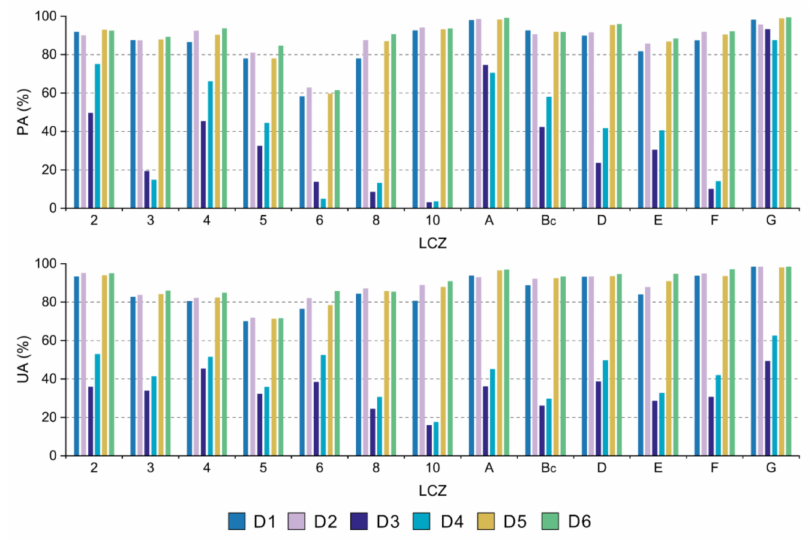
Figure 5. Producer’s accuracies (PAs) and user’s accuracies (UAs) of different LCZ maps obtained by RF classification using different datasets ( D1 – D6